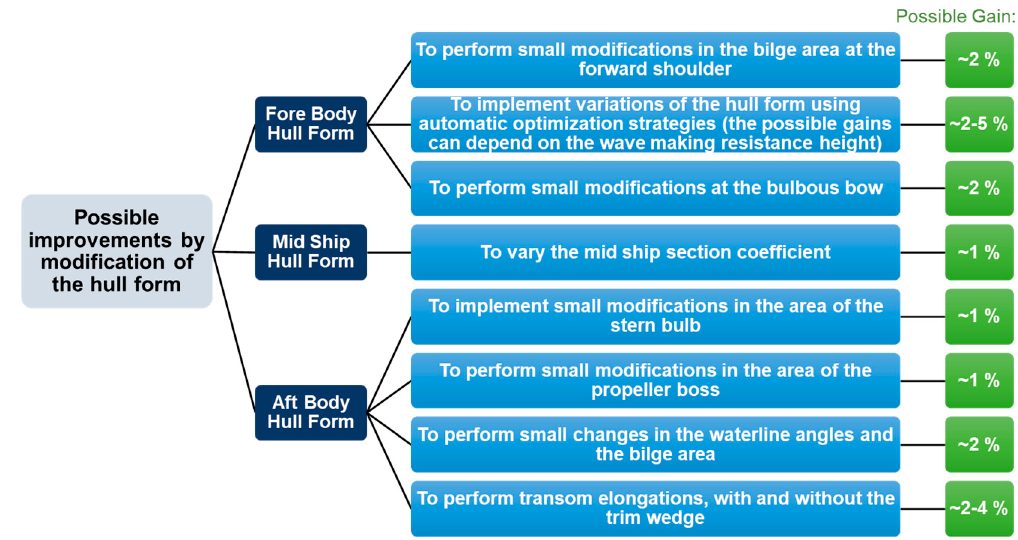
Figure 2. Possible gains in resistance reduction through permanent modifications of the hull, considering that the main dimensions of the vessel and the propeller diameter are unchanged. Modified from [32].